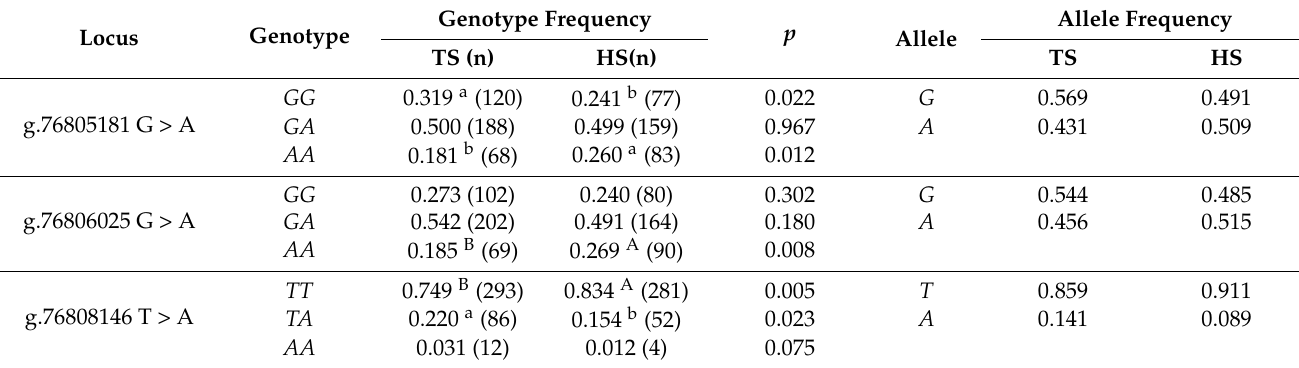
Table 2. Frequencies of genotype and allele in three positions of HIF-1 α gene in Tibetan sheep (TS) and Hu sheep (HS).